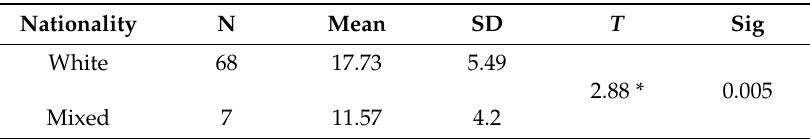
Table 2. t -test for nationality on attitudes towards help seeking (the table only depicts the groups that showed statistically significant results).